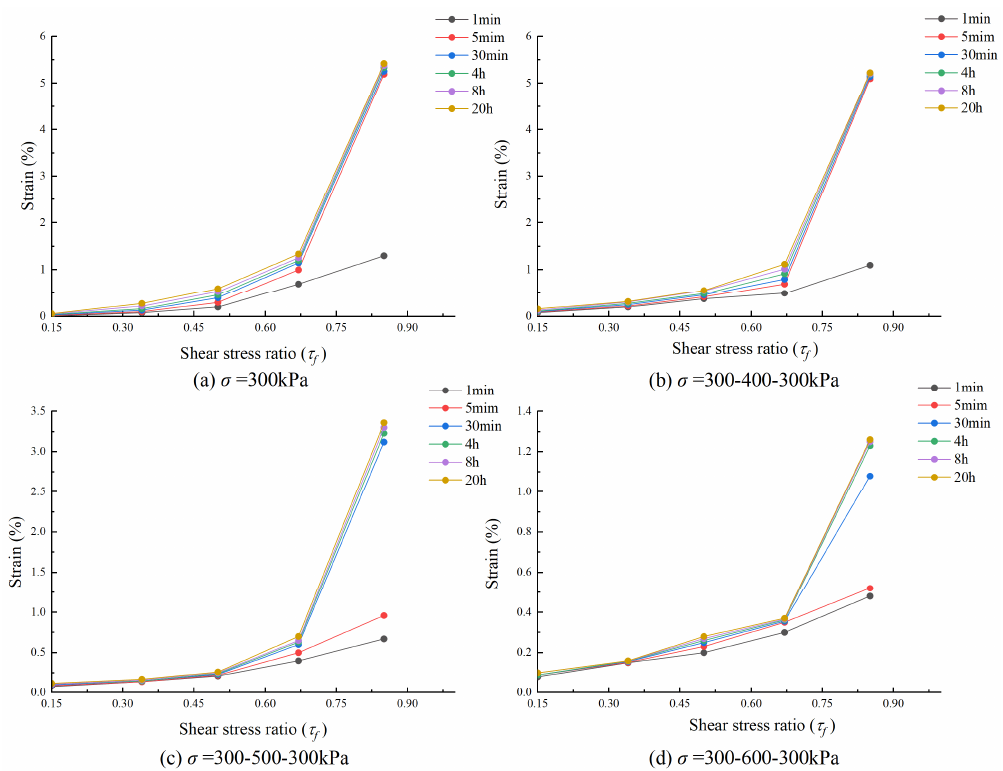
Figure 9. Stress–strain isochronous curve with different consolidation paths.